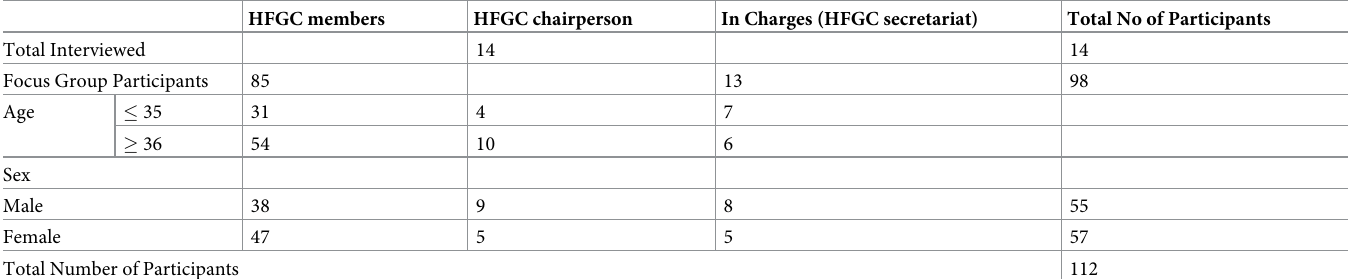
Table 1. Characteristics of the study